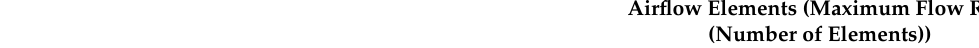
Table 1. Description of the parameters used as input for the simulation. The hallway is the same for both dwelling “A” and dwelling